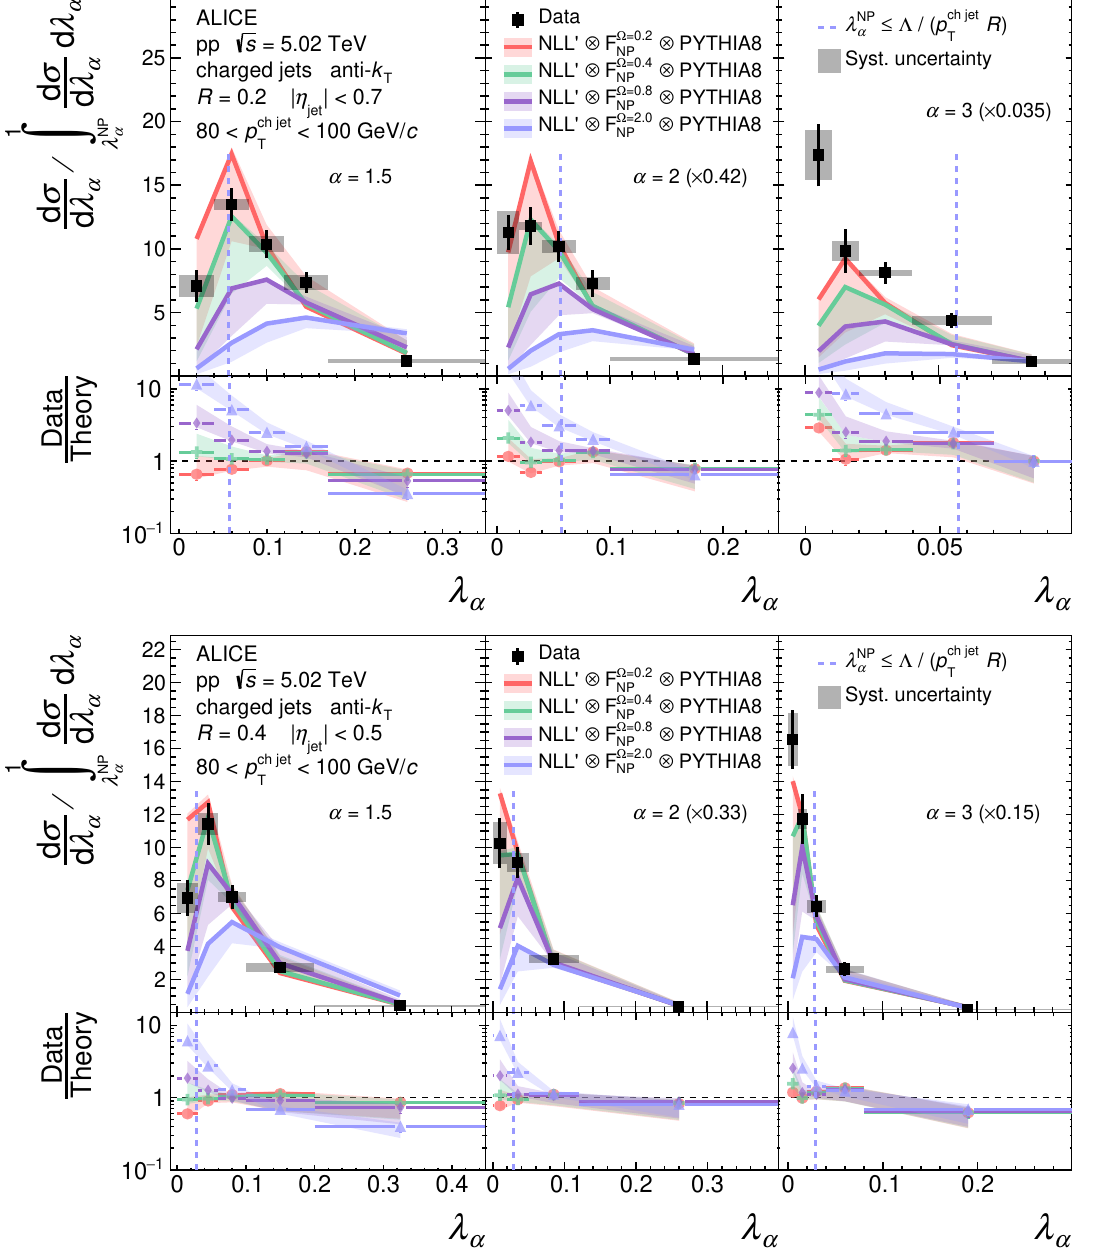
Figure 12 . Comparison of ungroomed jet angularities λ α in pp collisions for R = 0 . 2 (top) and R = 0 . 4 (bottom) to analytical NLL 0 predictions using F ( k ) convolution in the range 80 < p ch jet GeV /c . The distributions are normalized such that the integral of the perturbative region defined by λ α > λ NP (to the right of the dashed vertical line) is unity. Divided bins are placed into the left α (NP)